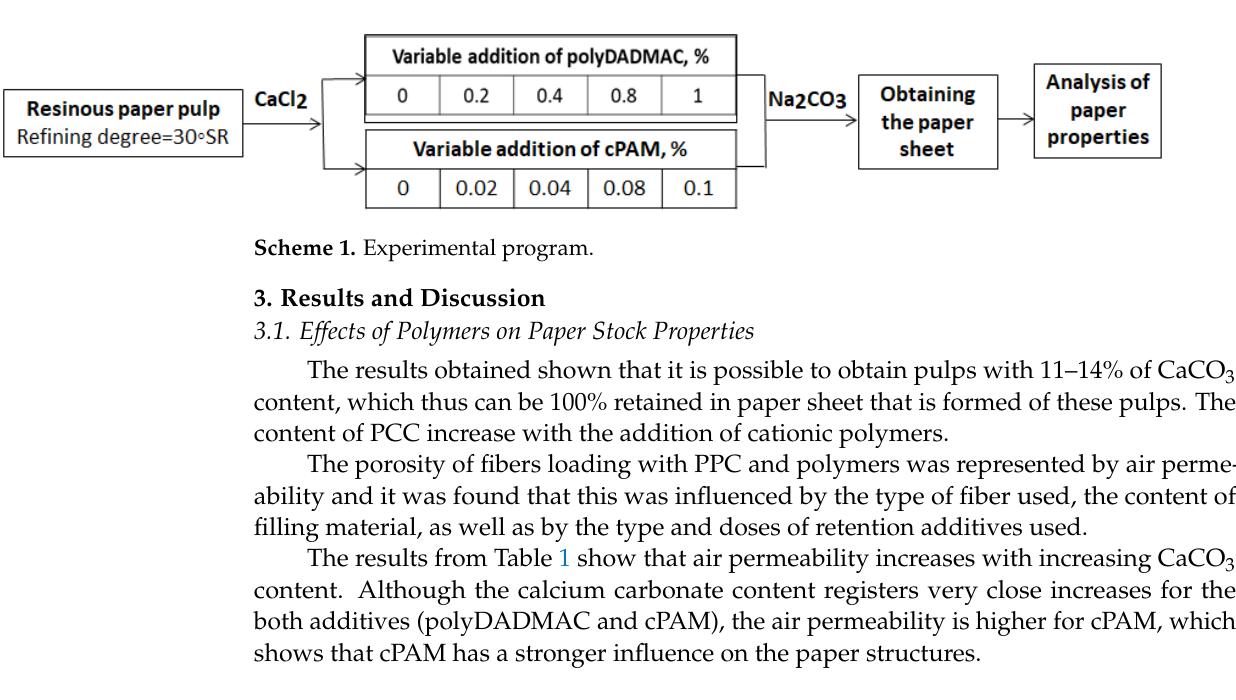
Table 1. The characteristics paper fibers obtained with 35% CaCO 3 for different percentages of polyDADMAC and cPAM polymers.